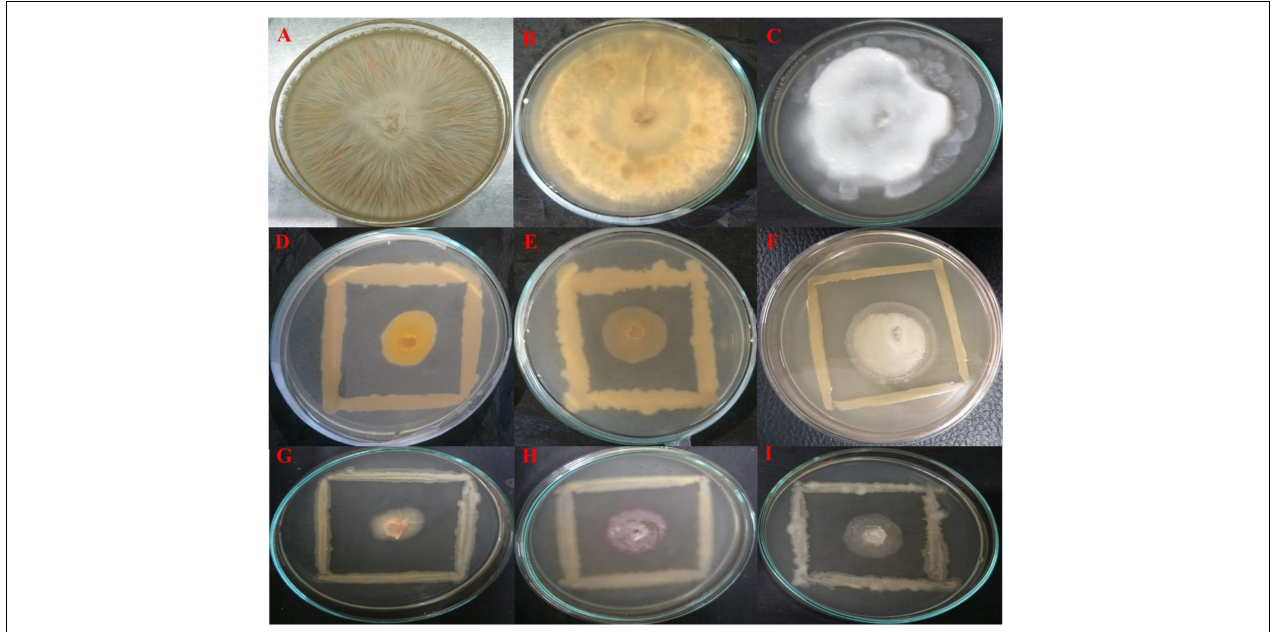
FIGURE 1 | Dual culture assay for investigating in vitro antagonistic potential of bacterial endophytes inhibiting the mycelial growth of fungal pathogens on PDA medium after 7 days of incubation. The endophytes antagonists OS_12 (D–F) and OS_25 (G–I) have limited the growth of hyphae of pathogens with respect to control plates which showed dense hyphal growth of fungal pathogens. (A) Fusarium oxysporum f. sp. pisi , (B) Rhizoctonia solani, and (C) . Pythium aphanidermatum